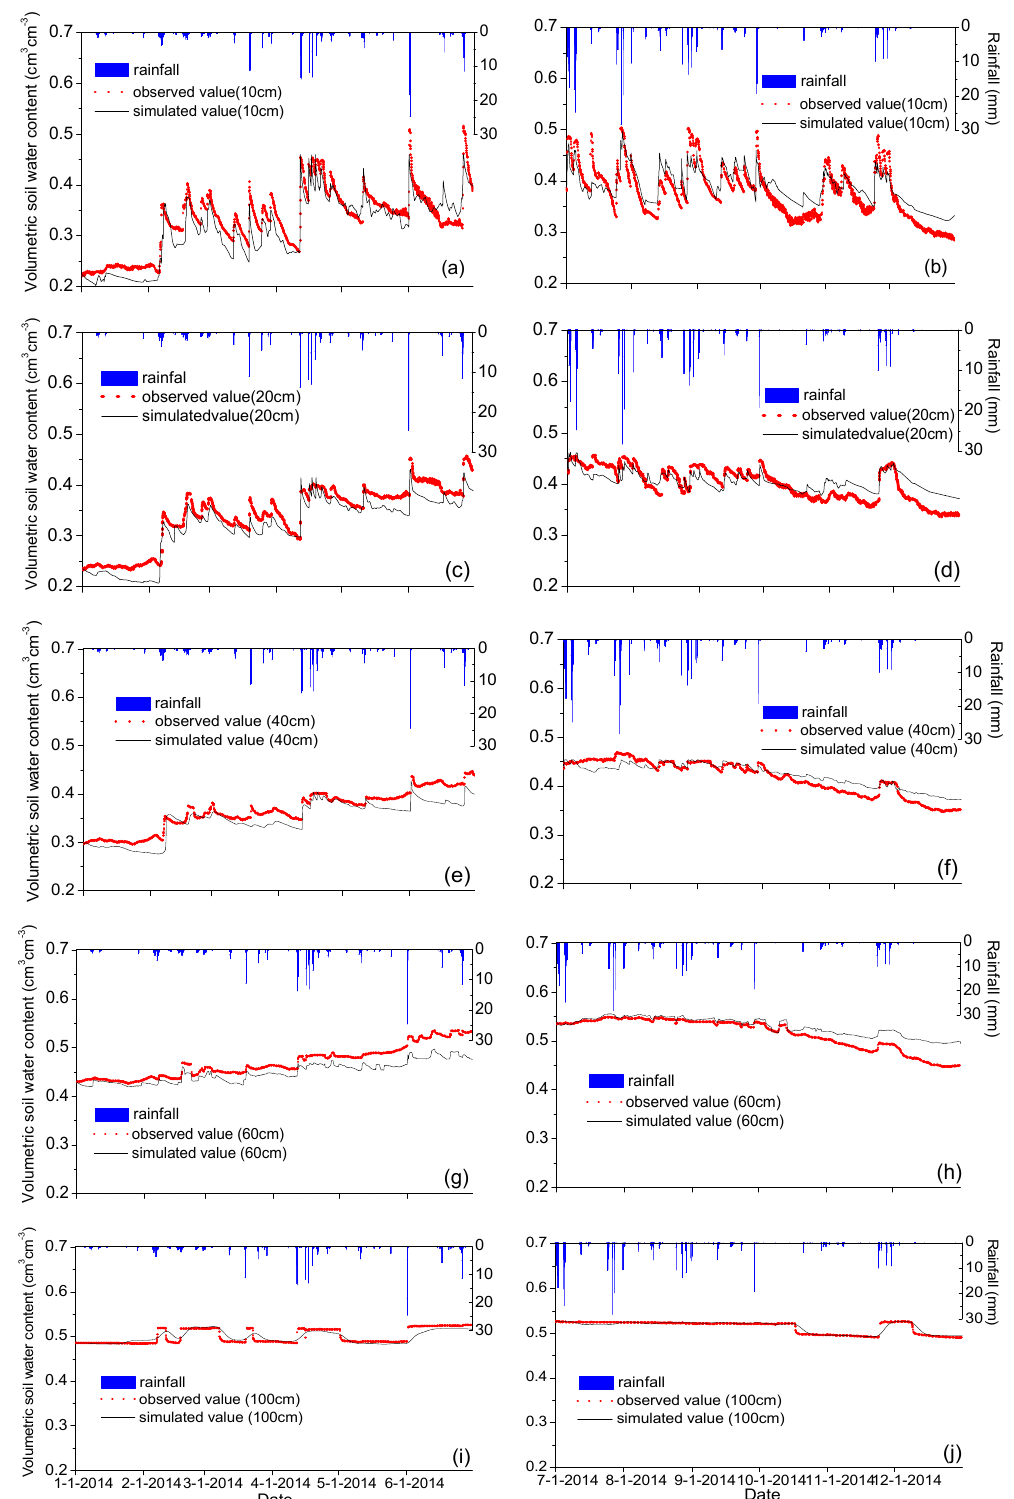
Figure 6. Simulated results (curves) versus observed (dots) soil water contents at different depths from 1 January 2014 to 30 June 2014 for calibration ( a , c , e , g , i ) and from 1 July 2014 to 31 December 2014 for validation ( b , d , f , h , j ). Daily rainfall measurements were also plotted.